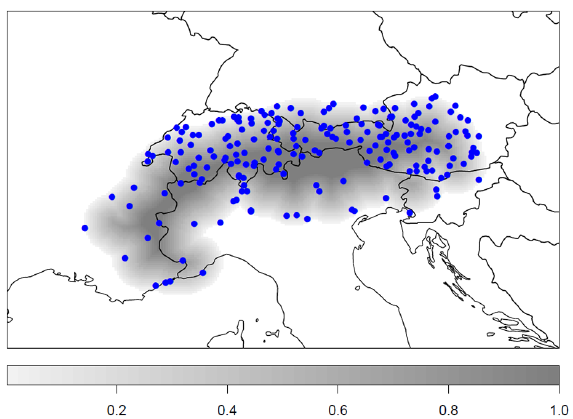
Figure 9. Alpine region (denoted region 8 in the following) intro- duced for the interpolation of wind